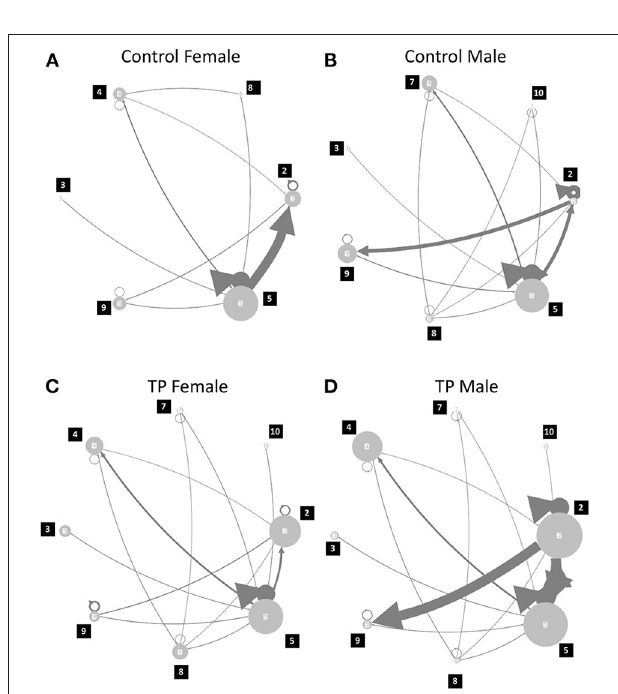
FIGURE 5 | Call type transition probability. (A) Control Female; (B) Control Male; (C) TP female; (D) TP male. Numbers of nodes described the call types, and the width of the edge with arrows represented the probability of transition from one call type to another. For example, transition from type 2 calls to type 9 calls were obvious in control and TP-treated males, as compared to control and TP-treated females. There were self-transitions observed and it was represented with circles and triangles in each node (e.g., call type 2 and